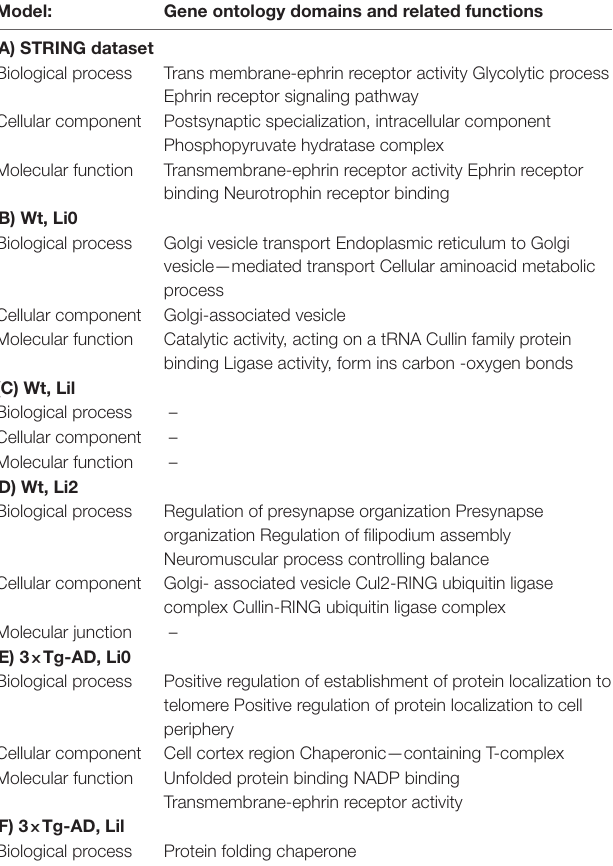
TABLE 3 | Over-represented ( p < 0.05) gene ontology (GO) domains and related functions indicative of neuron-glia interactions. Model: Gene ontology domains and related